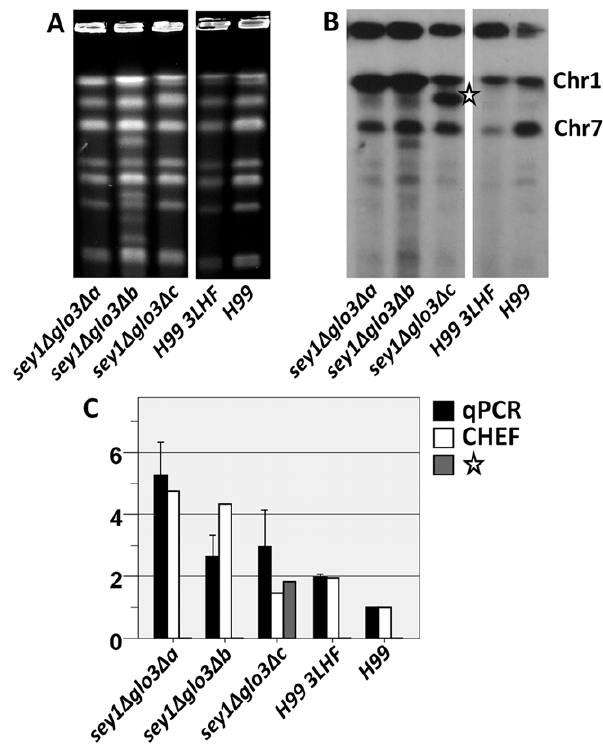
Figure 6. Analysis of the ERG11 chromosomal location in the Type2 sey1 D glo3 D clones. A ) CHEF gel analysis. Chromosomes of the indicated strains were separated by CHEF and stained with ethidium bromide. B ) Southern blot analysis. DNA of the CHEF gel was transferred to membrane and hybridized with ERG11 (Chr1) and CNAG_06646 (Chr7) probes. Star indicates the non-Chr1 located ERG11 . C ) Copy-number of ERG11 . White bar indicates the copy number of ERG11 from the CHEF quantified by phosphor-imager and the black bar represents the copy number of ERG11 analyzed by qPCR. Gray bar=non-Chr1 ERG11 indicates the copy number of ERG11 from the CHEF quantified by phosphor-imager of the band marked with a star from B). Error bar=2 SD.